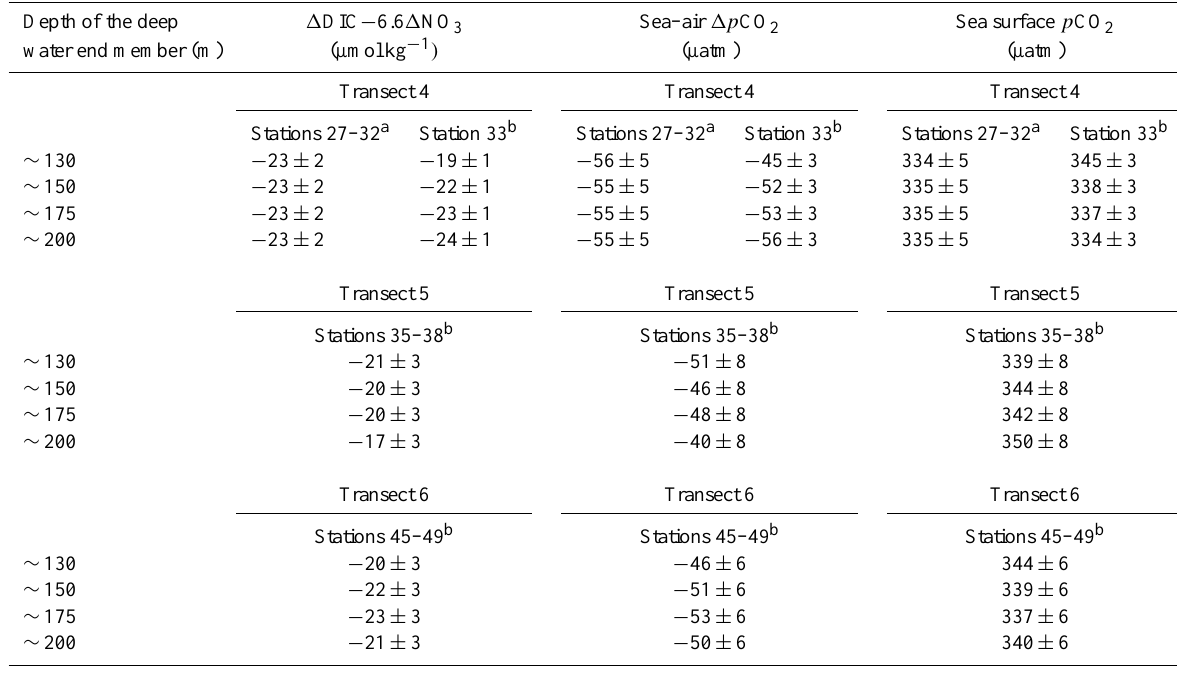
Table 2. Values of (cid:49) DIC − 6.6 (cid:49) NO 3 , sea–air (cid:49)p CO 2 and sea surface p CO 2 estimated with the deep water end member from different depths. Depth of the